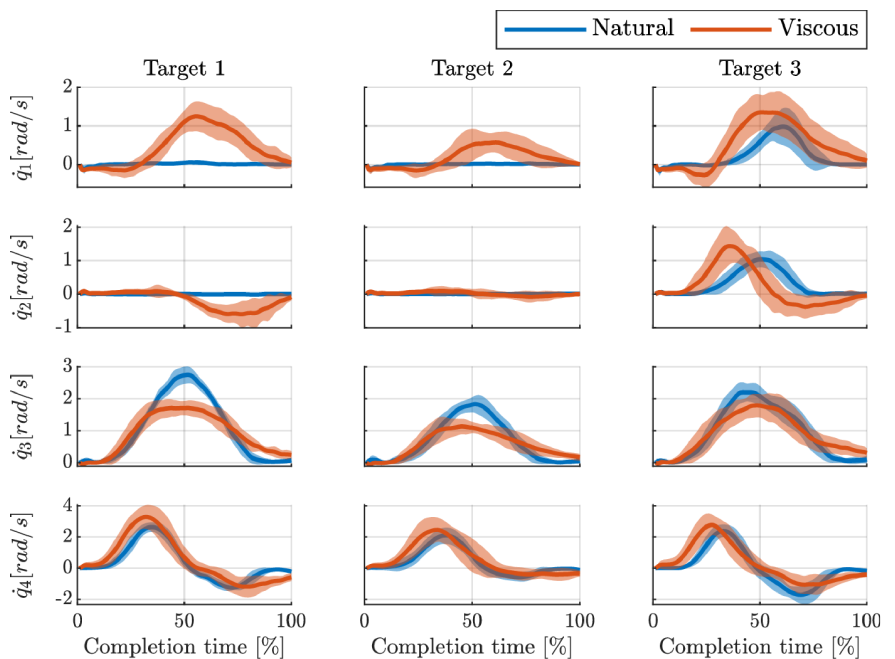
Fig 5. Comparison of a participant’s joint velocities when reaching the three targets in the two different conditions. The shaded areas represent the standard deviations.